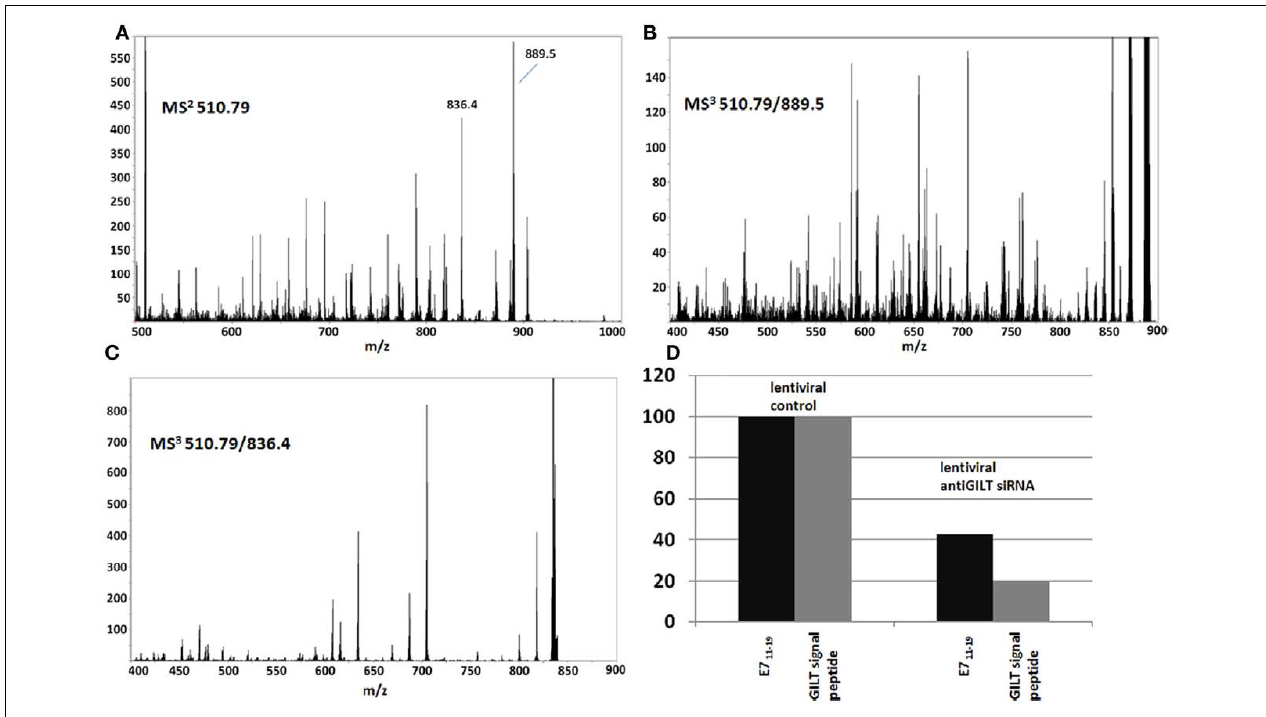
FIGURE 6 | siRNA suppression of GILT in CaSki cells shows that the abundance of GILT correlates with the abundance of the E7 11–19 peptide. siRNA suppression of GILT protein is correlated with a reduction in the amount of E7 11–19 peptide associated with HLA-A ∗ 02 in CaSki cells.The suppression of GILT is monitored by its signal peptide LLDVPTAAV and both the GILT and E7 11–19 peptides are characterized